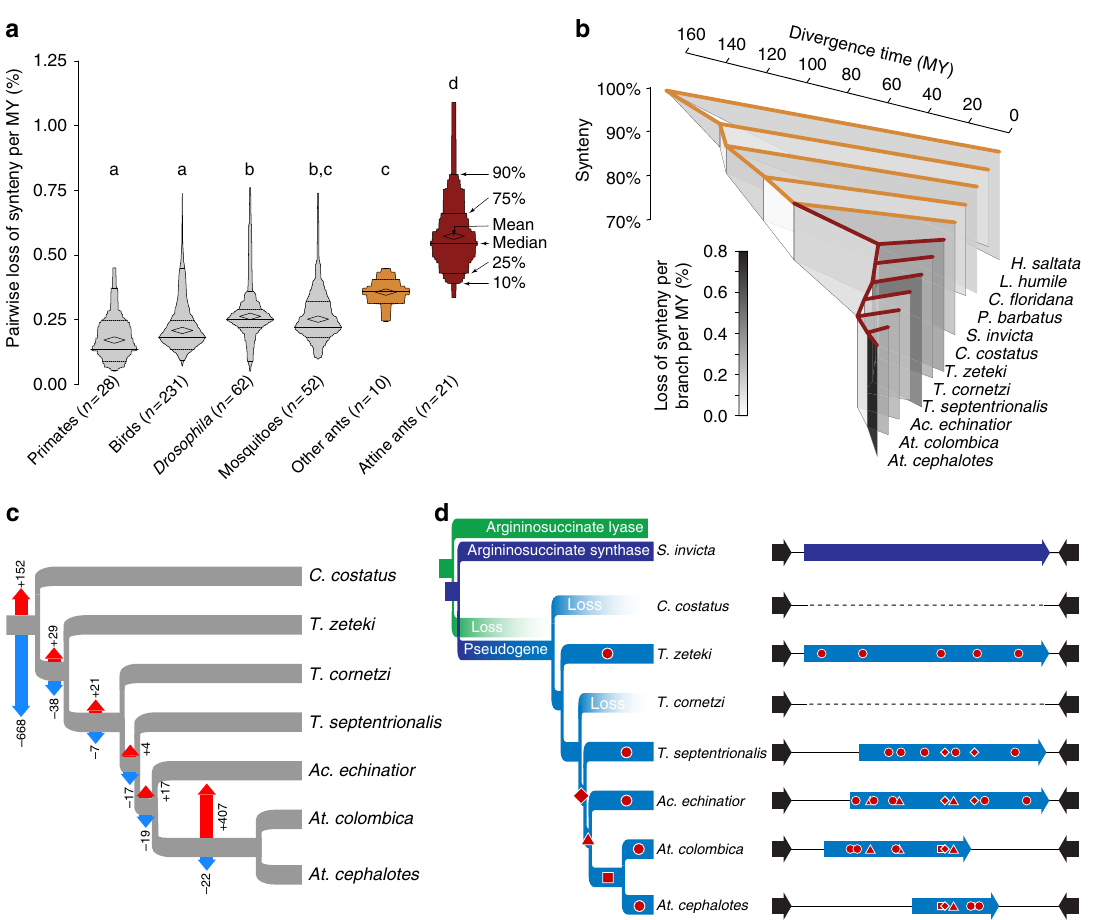
Figure 2 | Evolutionary changes in genomic arrangement and gene family sizes in attine ants. ( a ) Attine synteny loss per MYdivergence compared with other lineages with sequenced genomes. Box-percentile plots summarize the distribution of pairwise comparisons (number given after lineage name) within each clade, with means and percentiles marked. The overall difference between lineages was highly significant ( n ¼ 6, Kruskal–Wallis H ¼ 101.247, P o 0.0001). Shared letters indicate groups that did not differ significantly (Steel–Dwass test, P 4 0.05). ( b ) Synteny loss mapped onto the phylogeny of all ants with sequenced genomes, comparing each node with the earliest common ancestor (vertical axis) and with polygons shaded according to rate of loss per branch. ( c ) Numbers of expanded (red arrows) or contracted (blue arrows) gene families inferred from observed gene family sizes at terminal branches. ( d ) Functional erosion of the arginine synthesis pathway, with the argininosuccinate lyase gene (green) probably being lost in the attine ancestor and the argininosuccinate synthase gene (blue) remaining recognizable as pseudogenized residues in some genomes. Approximate lengths of pseudogenes (light blue bars) are shown relative to the S. invicta coding sequence of 1,239bp. Red symbols in the branches and bars mark the origins and approximate locations of indels or in-frame stop codons: dots: lineage specific mutations; diamonds: ancestral mutations for T. septentrionalis , Acromyrmex and Atta ; triangles: ancestral mutations for Acromyrmex and Atta ; squares: ancestral mutations for Atta